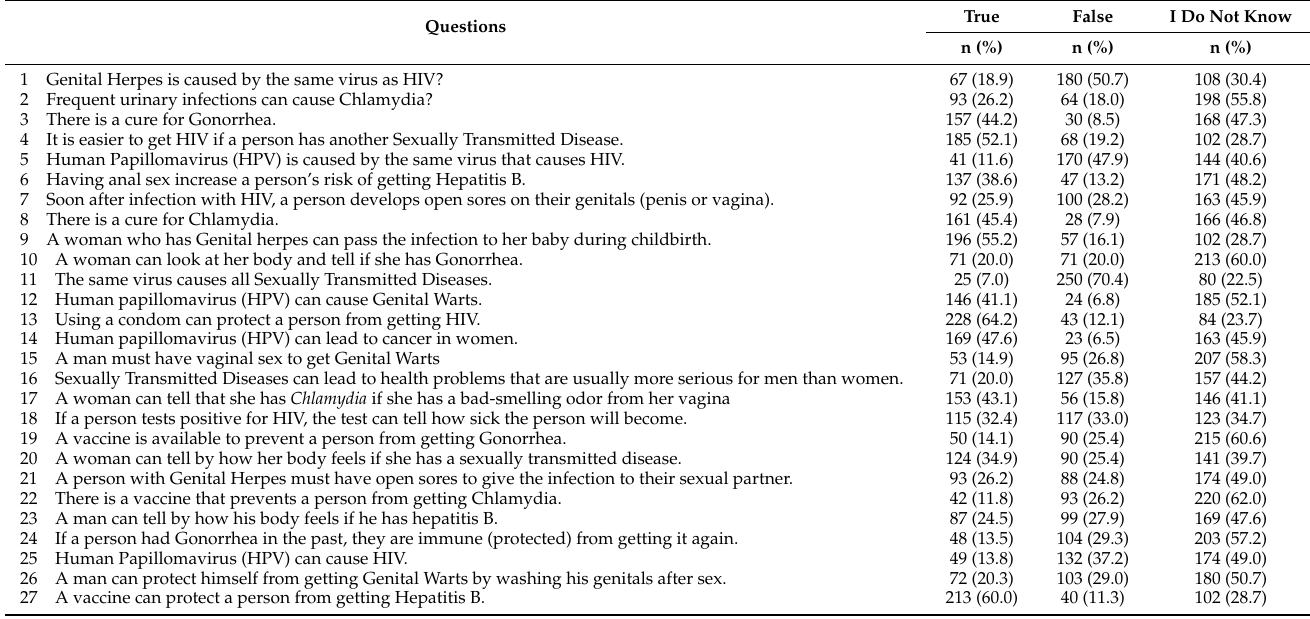
Table 3. Assessment of the female knowledge about different STDs.